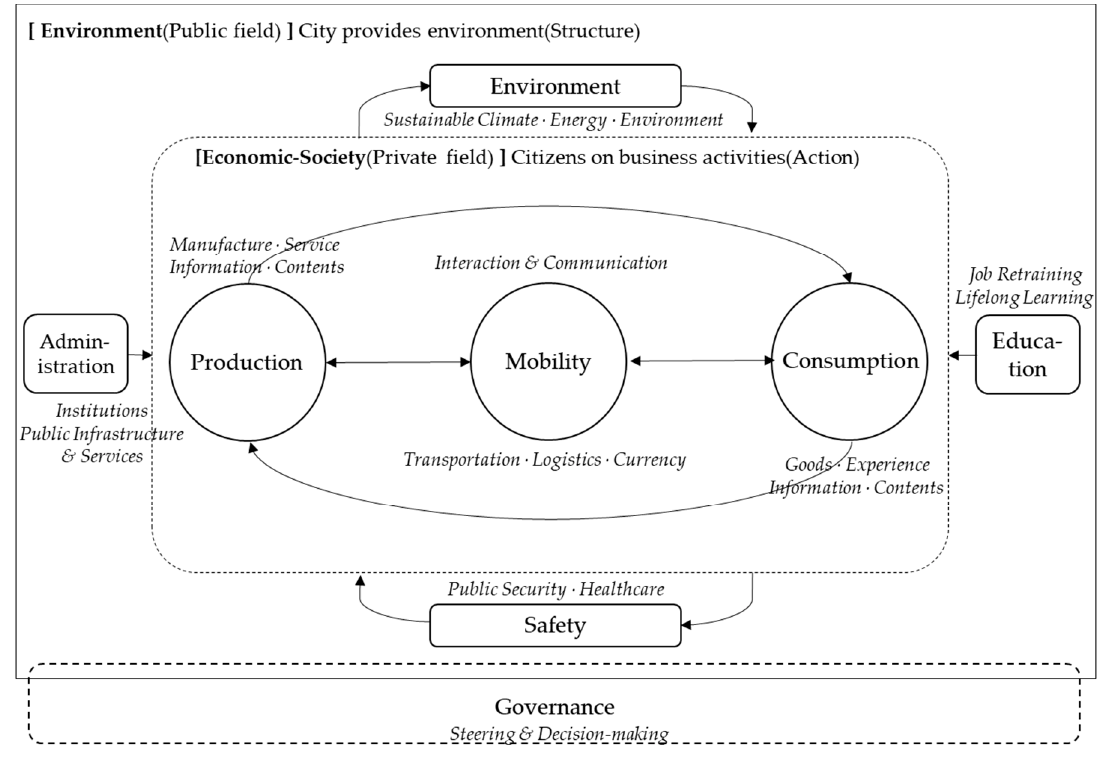
Figure 3. Smart City Social Model. J. Open Innov. Technol. Mark. Complex. 2019 , 5 , x FOR PEER REVIEW